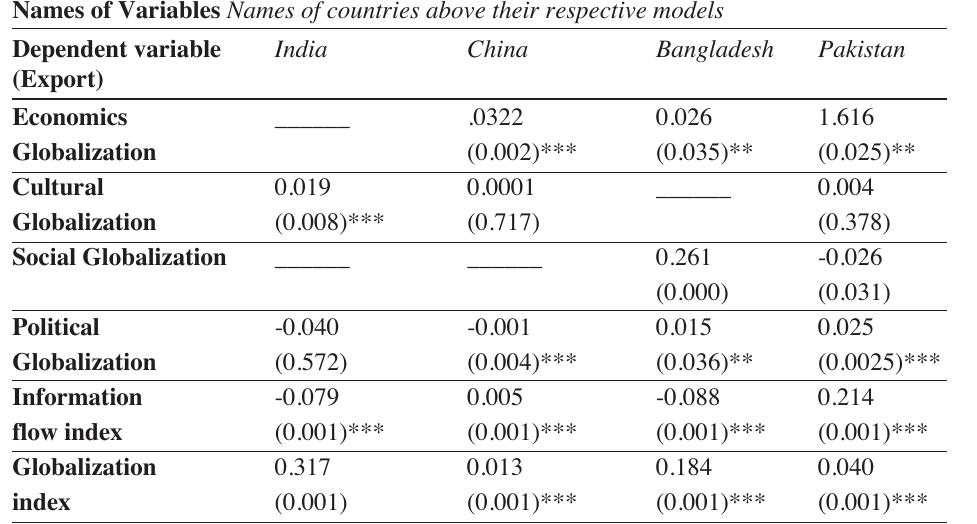
The values in parenthesis represent with three steric*** that it is significant at 1% level, with two steric** significant at 5% level of significant and one steric* indicate that it is significant at 10% level of signifi-